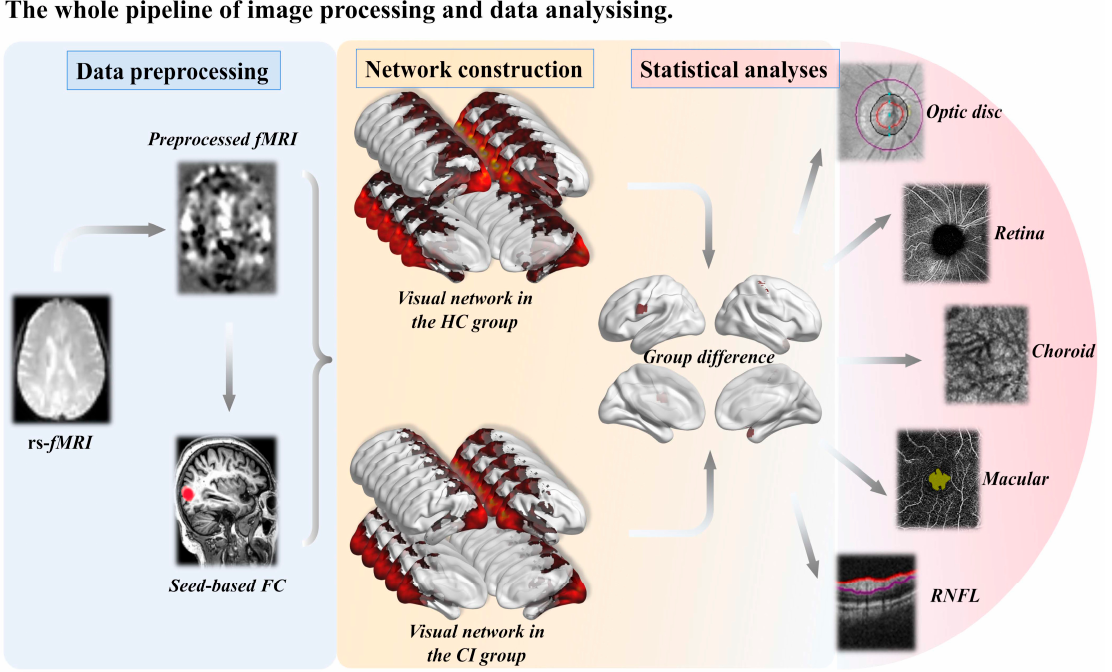
Figure 1. A flowchart illustrates the entire process of image processing and data analysis, which involves the subjects of cognitive impairment (CI) and healthy controls (HC), and measures retinal nerve fiber layer